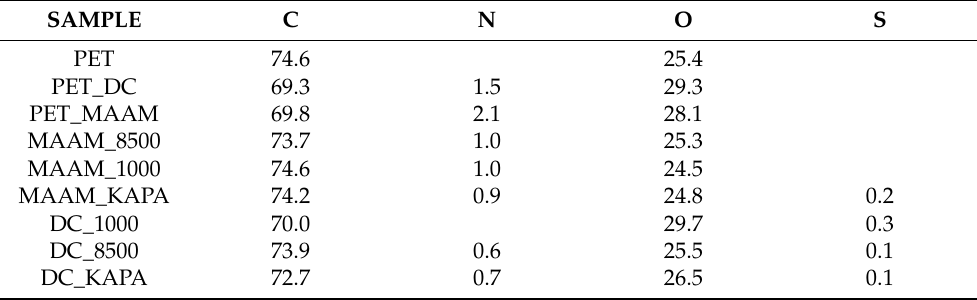
Table 2. Surface elemental compositions of the samples (%) from XPS measurements.